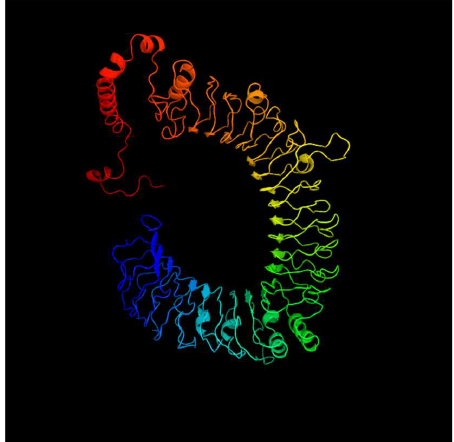
Fishes 2022 , 7 , x FOR PEER REVIEW Figure 4. Predicted tertiary structure of tlr1 . Figure 4. Predicted tertiary structure of tlr1 .